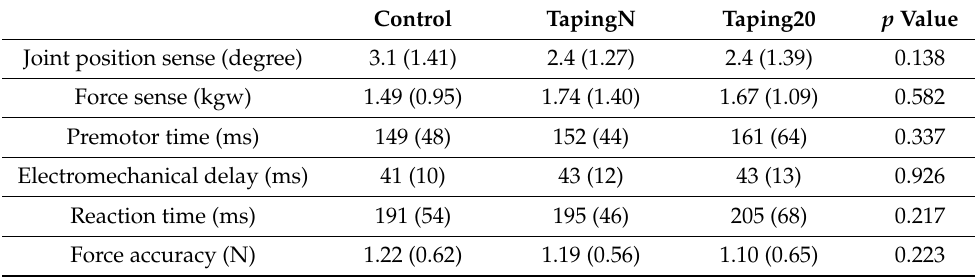
Figure 2. ( A ) Joint and force proprioceptive performance among 3 taping conditions. Neither joint nor force proprioception differed significantly among conditions. ( B ) Participants with poor joint proprioceptive sense showed improved smaller joint degree errors under the tapingN condition and taping20 condition compared with the control condition. * indicates significant difference between conditions ( p < 0.05). Table 1. Sensorimotor performance under the three different taping